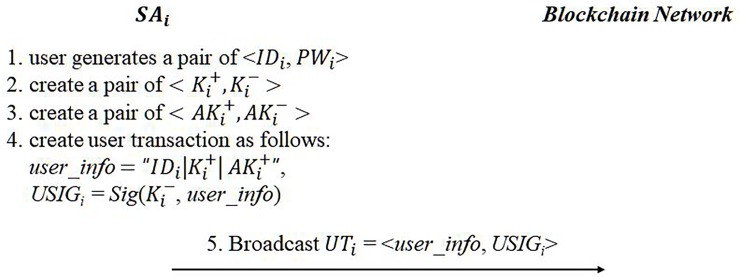
User registration.